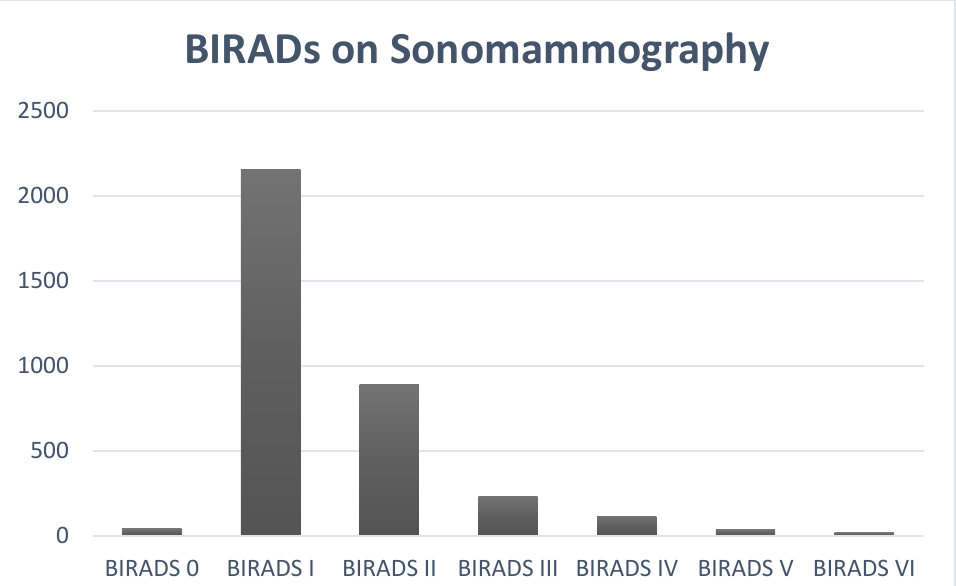
Figure 7. The BIRAD categorization on sonomammography.